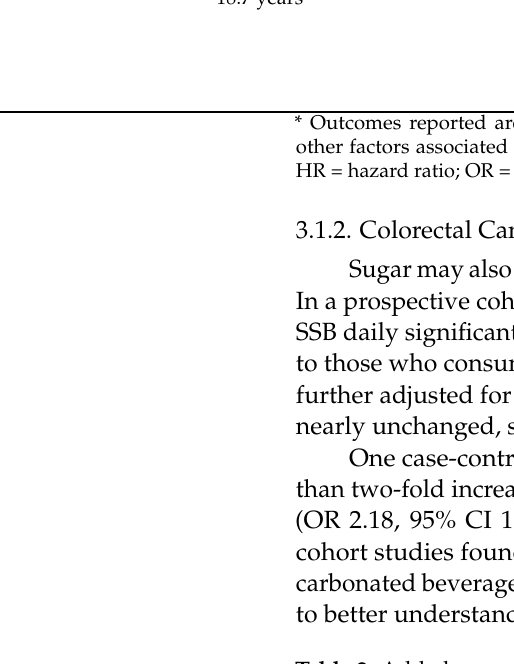
Table 2. Added sugar intake and risk of developing colorectal cancer and